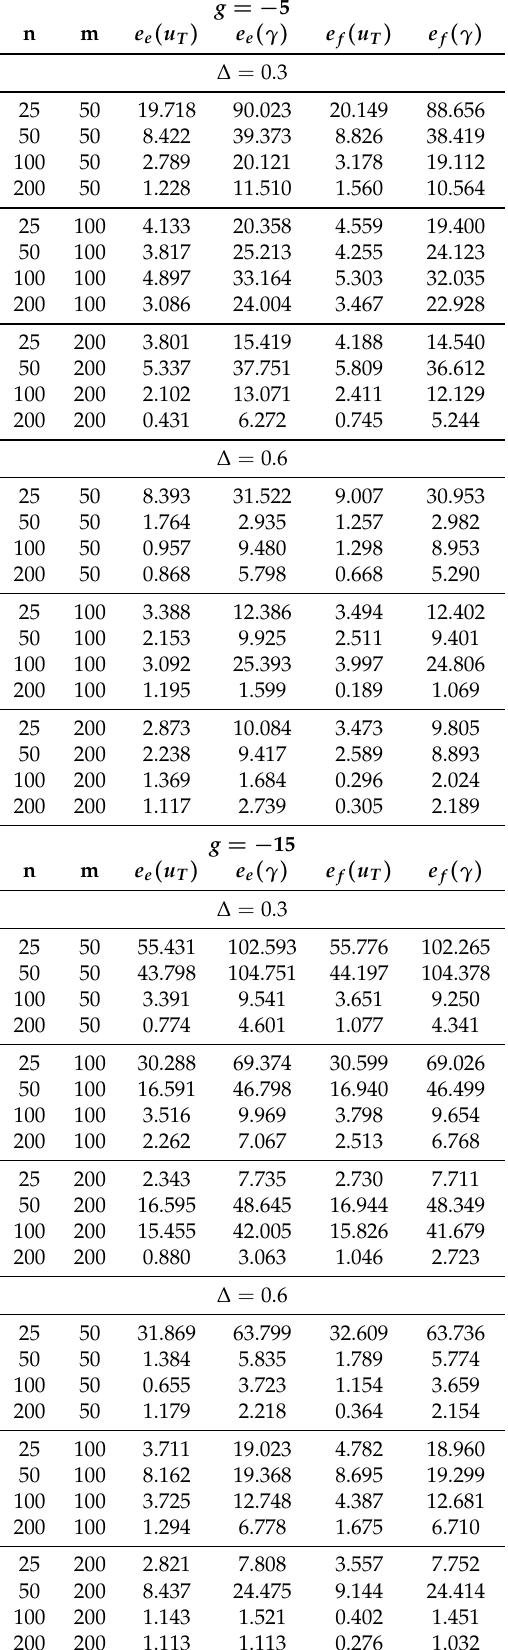
Table 3. One-dimensional problem with delta-smoothing. Relative L 2 error for temperature at the final time and phase change interface location with respect to the exact solution and a very fine grid